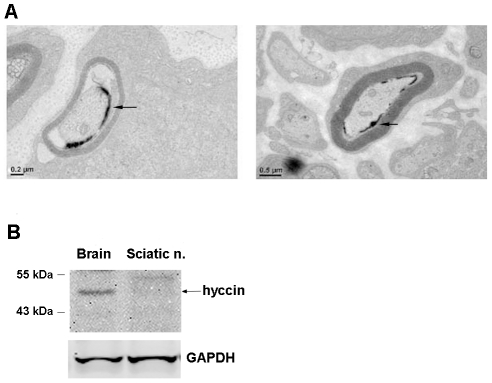
Analysis of Hyccin expression in the PNS.Panel A: Semithin sections of sciatic nerves isolated from Hyccin KO mice (n = 3) were stained with Bluo-Gal and analyzed by electron microscopy. Arrows point to Hyccin-LacZ signal. Panel B. Immunoblot analysis of hyccin protein in sciatic nerve lysates isolated from P10 WT mice as compared to total brain lysates. Note that Hyccin protein levels is very low in the mature sciatic nerve sample. GAPDH was utilized as a sample loading control.